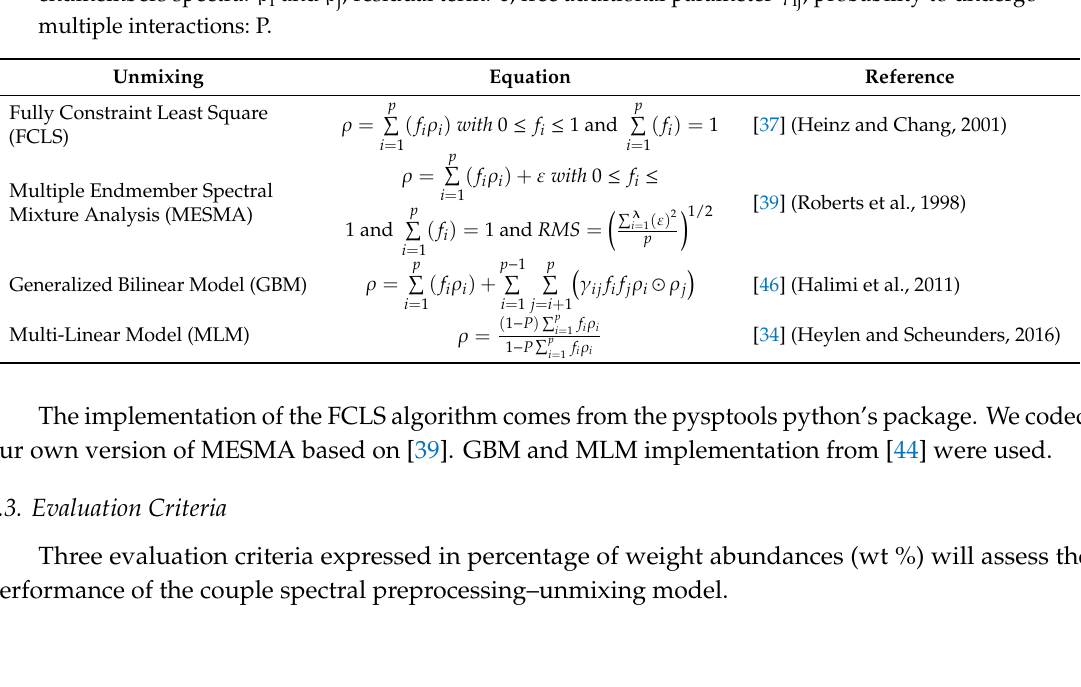
Table 2. Selected spectral preprocessing methods: reflectance at wavelength λ : ρ λ , averaged reflectance: ρ , wavelet-base function: ψ , wavelet scale: S, cosinus of the incident zenithal angle: µ viewing zenithal angle: µ , the half width of the smooth filter: m, smoothed spectra: ρ smoothing window: ρ j , coe ffi cient of the i th point of the filter of the q th order of derivative: P